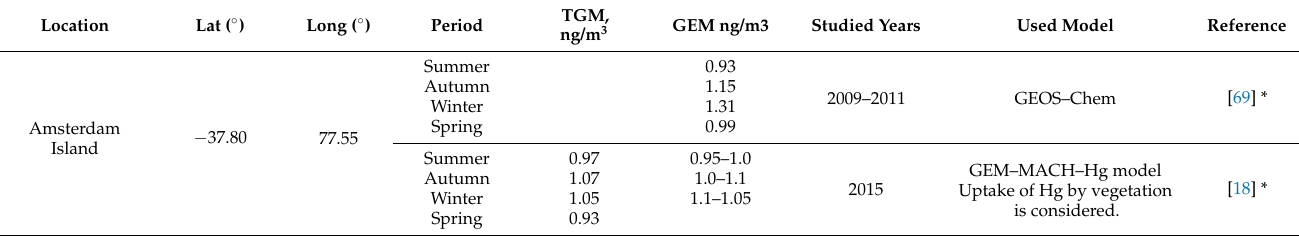
Table 2. Different values for TGM and GEM were obtained by simulation models for the SH. To achieve values for each season, the data for * studies are interpreted from graphs and tables. The seasons are summer between January and March, Autumn between April and June, Winter between July and September, and Spring between October and